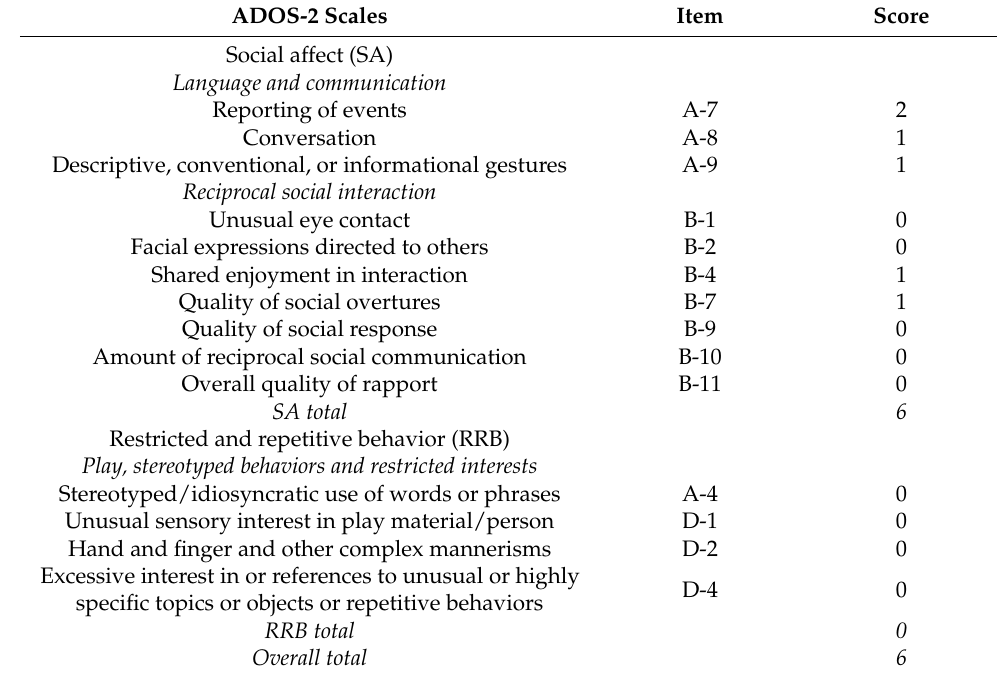
Table 1. Results of the Assessment of Core Symptoms of Autism using ADOS-2 (Module 3). ADOS-2 Scales